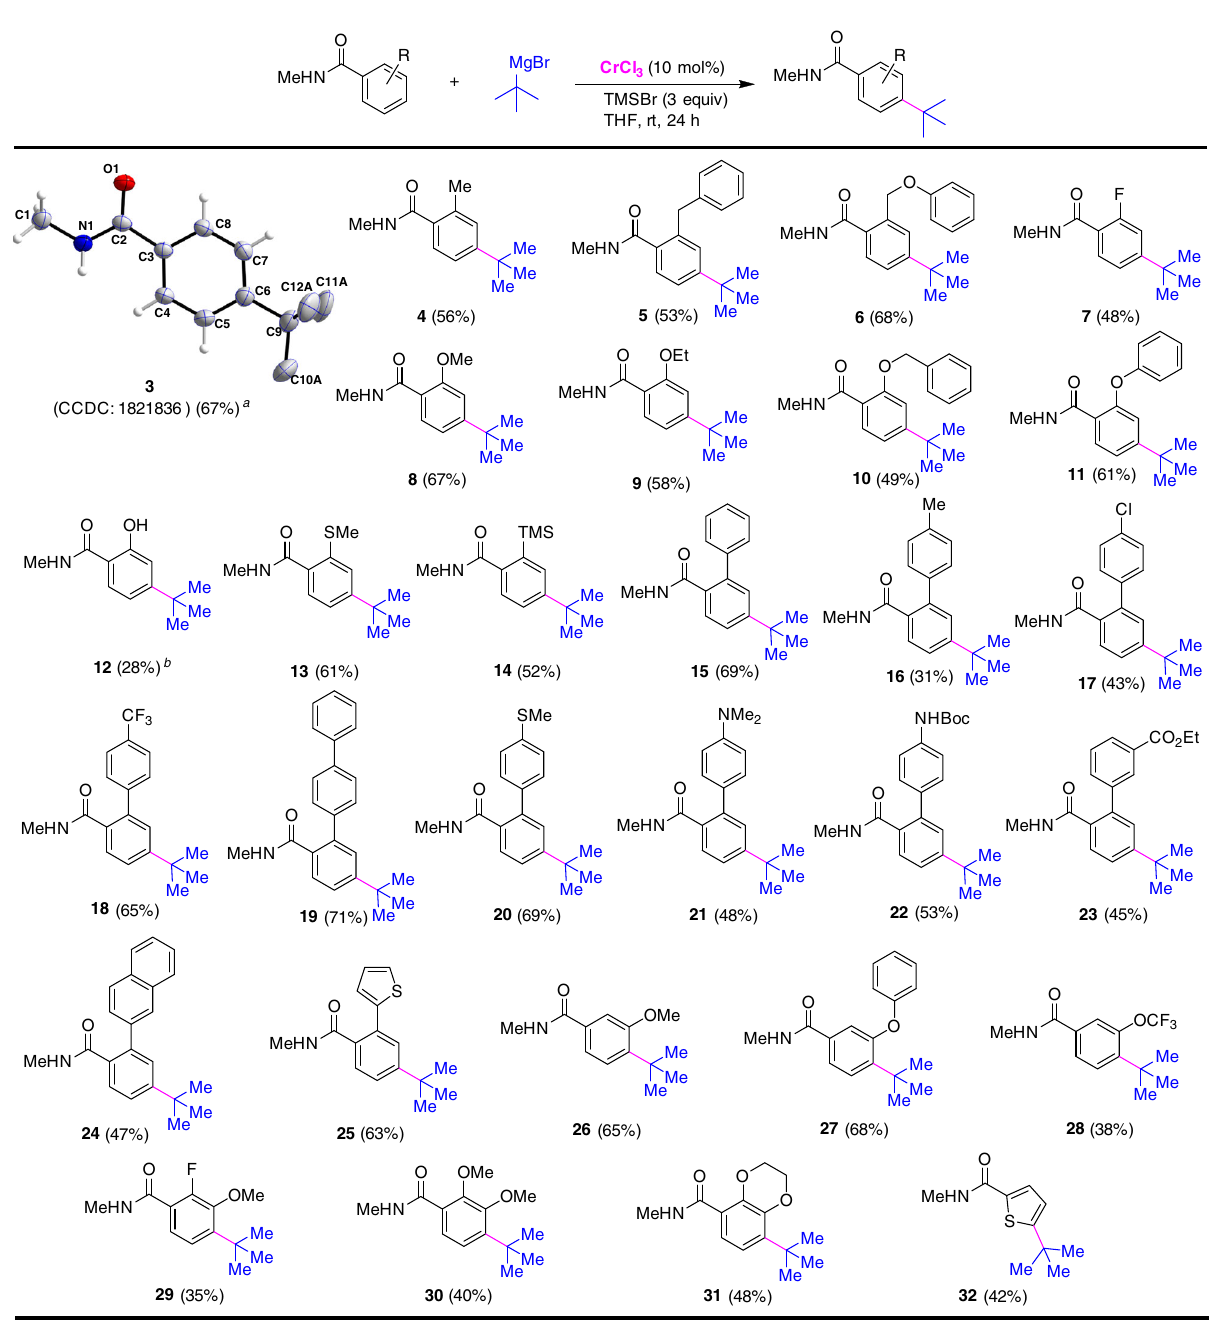
Fig. 2 Cr-catalyzed para -selective alkylation of benzamides with tert -butyl Grignard reagent. Conditions: N -methylbenzamide derivative (0.2 mmol), tert - butylmagnesium bromide (0.8 mmol), CrCl 3 (0.02 mmol), TMSBr (0.6 mmol), THF (0.5 mL), rt, 24 h. Isolated yields are given. a Yield of gram-scale reaction with 1a (10 mmol, 1.36 g). b Tert -butylmagnesium bromide (1 mmol) was